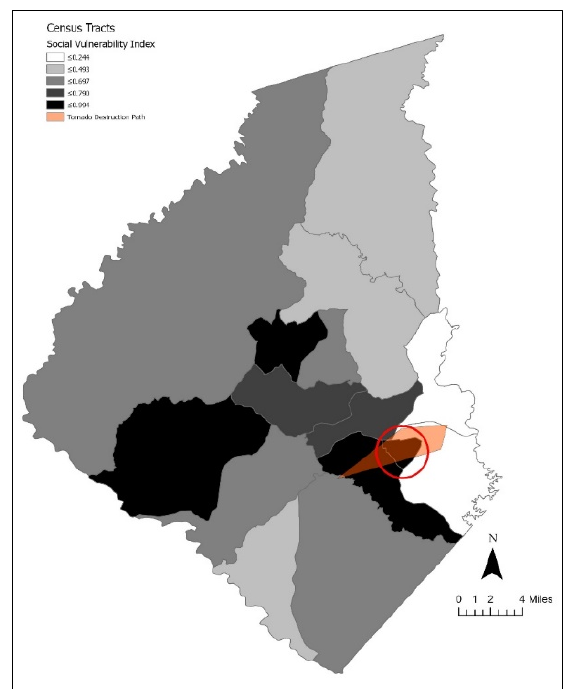
Figure 3. Social Vulnerability Index (Household Composition and Disability) by Census Tract